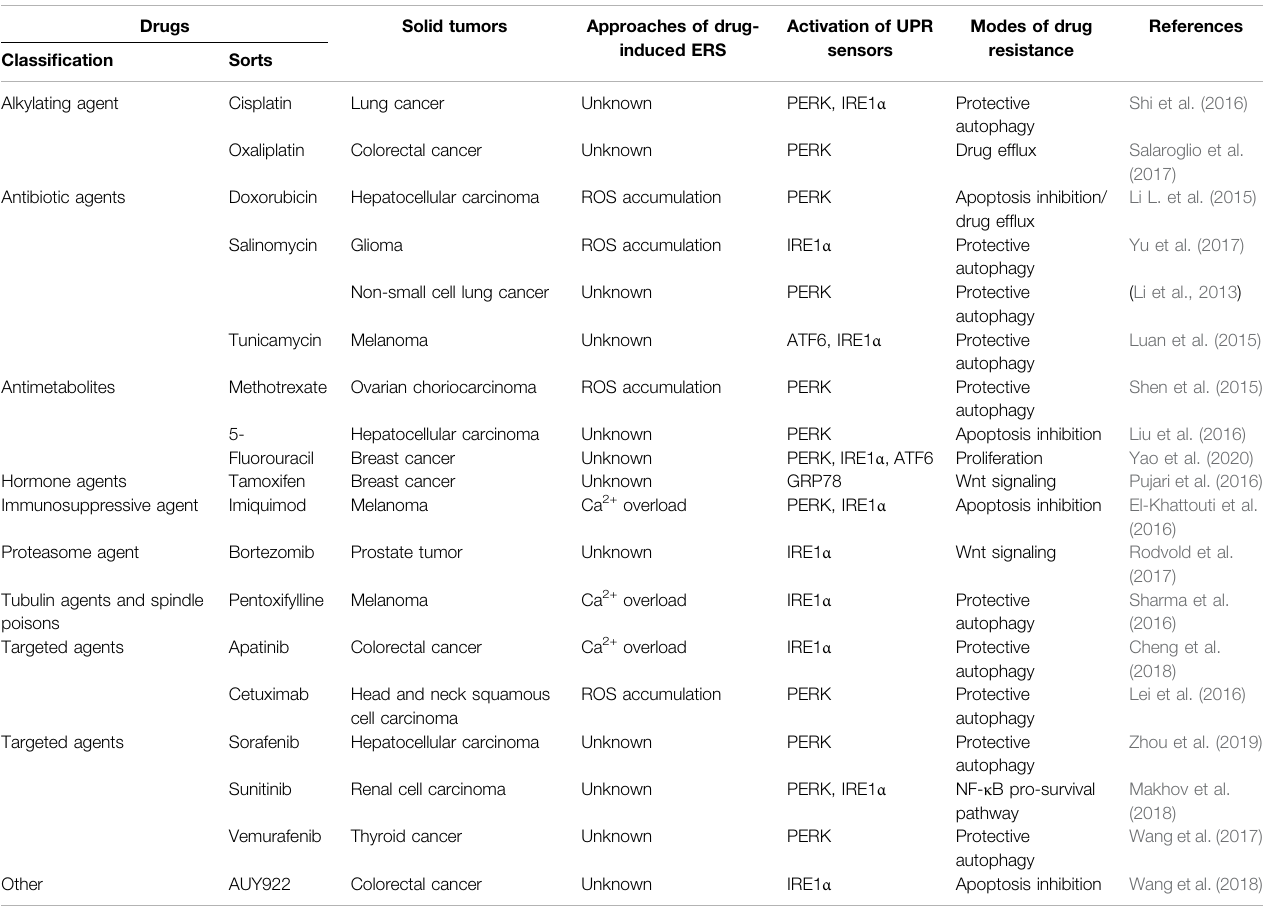
TABLE 1 | Approaches of intrinsic drug-induced ERS causing drug resistance in solid